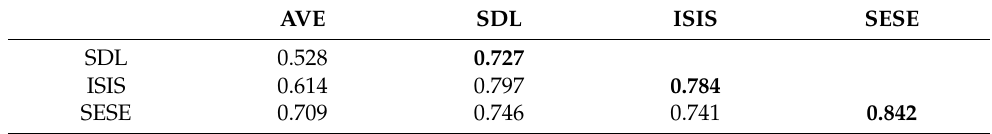
Table 5. Discriminant validity for the measurement